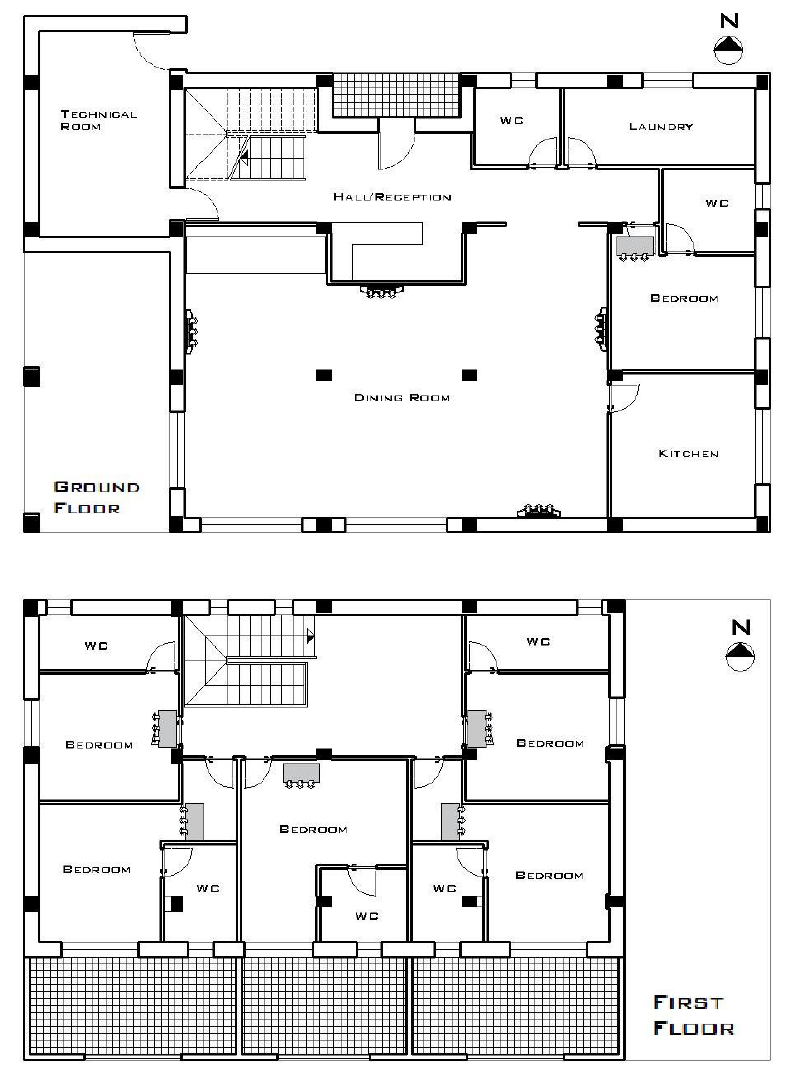
Figure 3. Plan of the ground floor and first floor of the case study building.